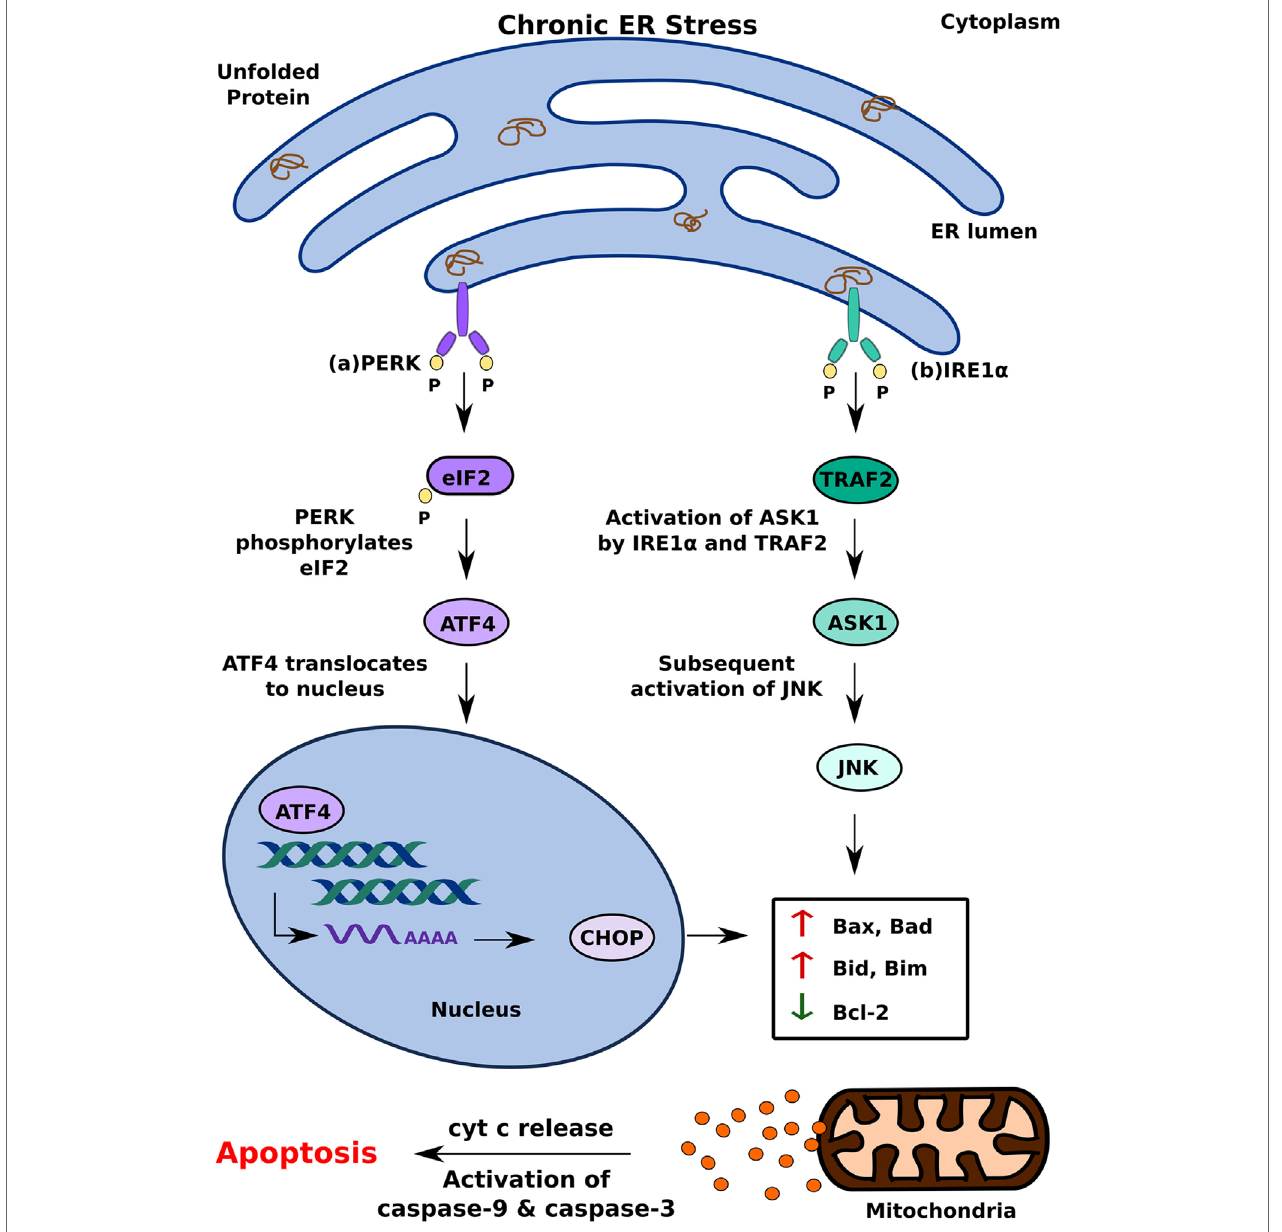
FigURe 2 | Pro-apoptotic unfolded protein response (UPR) response under chronic endoplasmic reticulum (ER) stress. When UPR is dysfunctional, cell undergoes apoptosis by (A) PERK mediated production of CHOP and (B) inositol-requiring 1 α -induced activation of ASK1. This leads to cytochrome c (cyt c) release and eventual